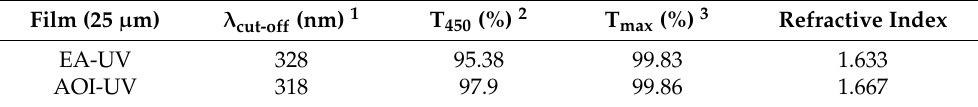
Figure 9. Comparison of optical transmission and photographs of high refractive index cured films. Table 2. Comparative transmittance and refractive index of UV-curable films.